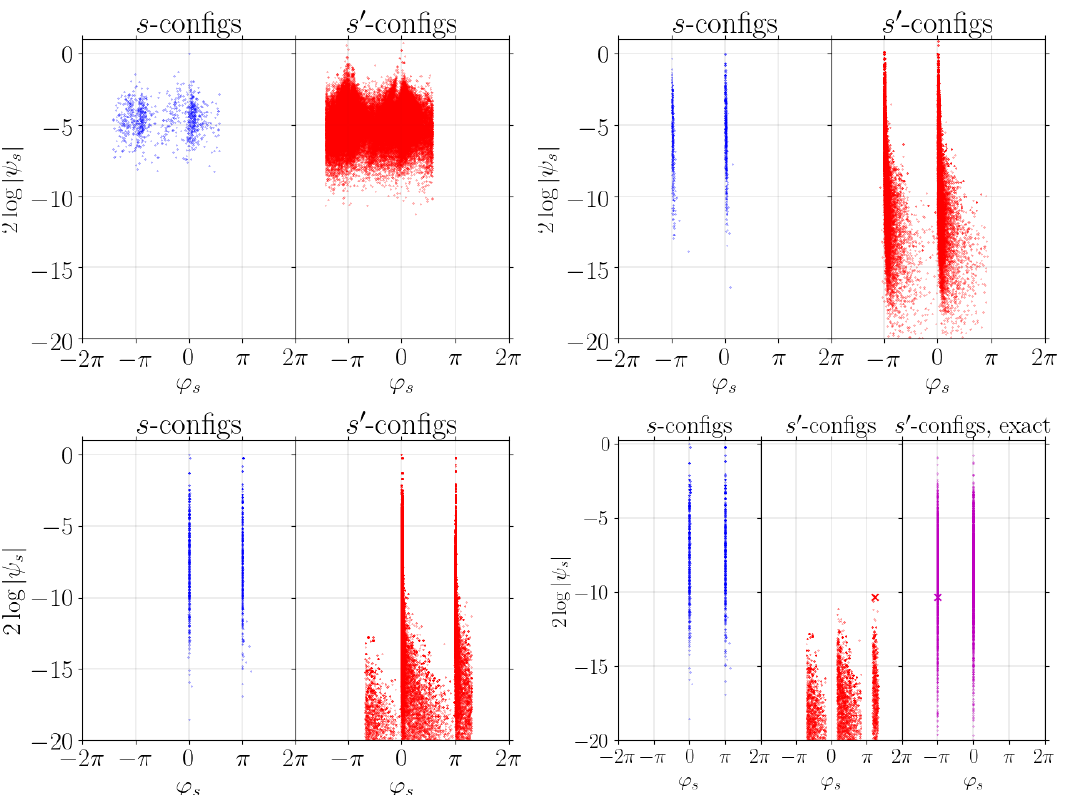
Figure 7: Snapshots of the distribution of phases and magnitudes at increasing opti- mization iterations during training (top left: 200, top right: 500, bottom left: 1995) shows the emergent of two phase peaks, a distance π -apart, signaling the approach to the real-valued ground state wave function (see text). Left panels (blue): a s -sample of 10 3 configurations drawn from the log-amplitude network. Right panels (red): spin configurations that contribute to the local energy and have a nonzero Hamil- tonian matrix element ( s (cid:48) -sample). Bottom right: at iteration 1995 subtracting the = 0, ± π leaves only the peaks from the s (cid:48) -sample (middle) in an (cid:34) = 0.5 vicinity of ϕ s mismatch configurations (red, middle), whose amplitudes and signs are compared against the exact ground state values (right, magenta). The position of the largest- amplitude s (cid:48) -configuration is held fixed and is denoted by a red cross. The system / J = 0.5. Op- size is N = 6 × 6. The network architecture is listed in App. H, and J 2 1 timization was done using RK in combination with SR, see App. A. The MC sample = 2 15 . Note that the values on the y -axes are not absolute, since neural size is N MC quantum states are not